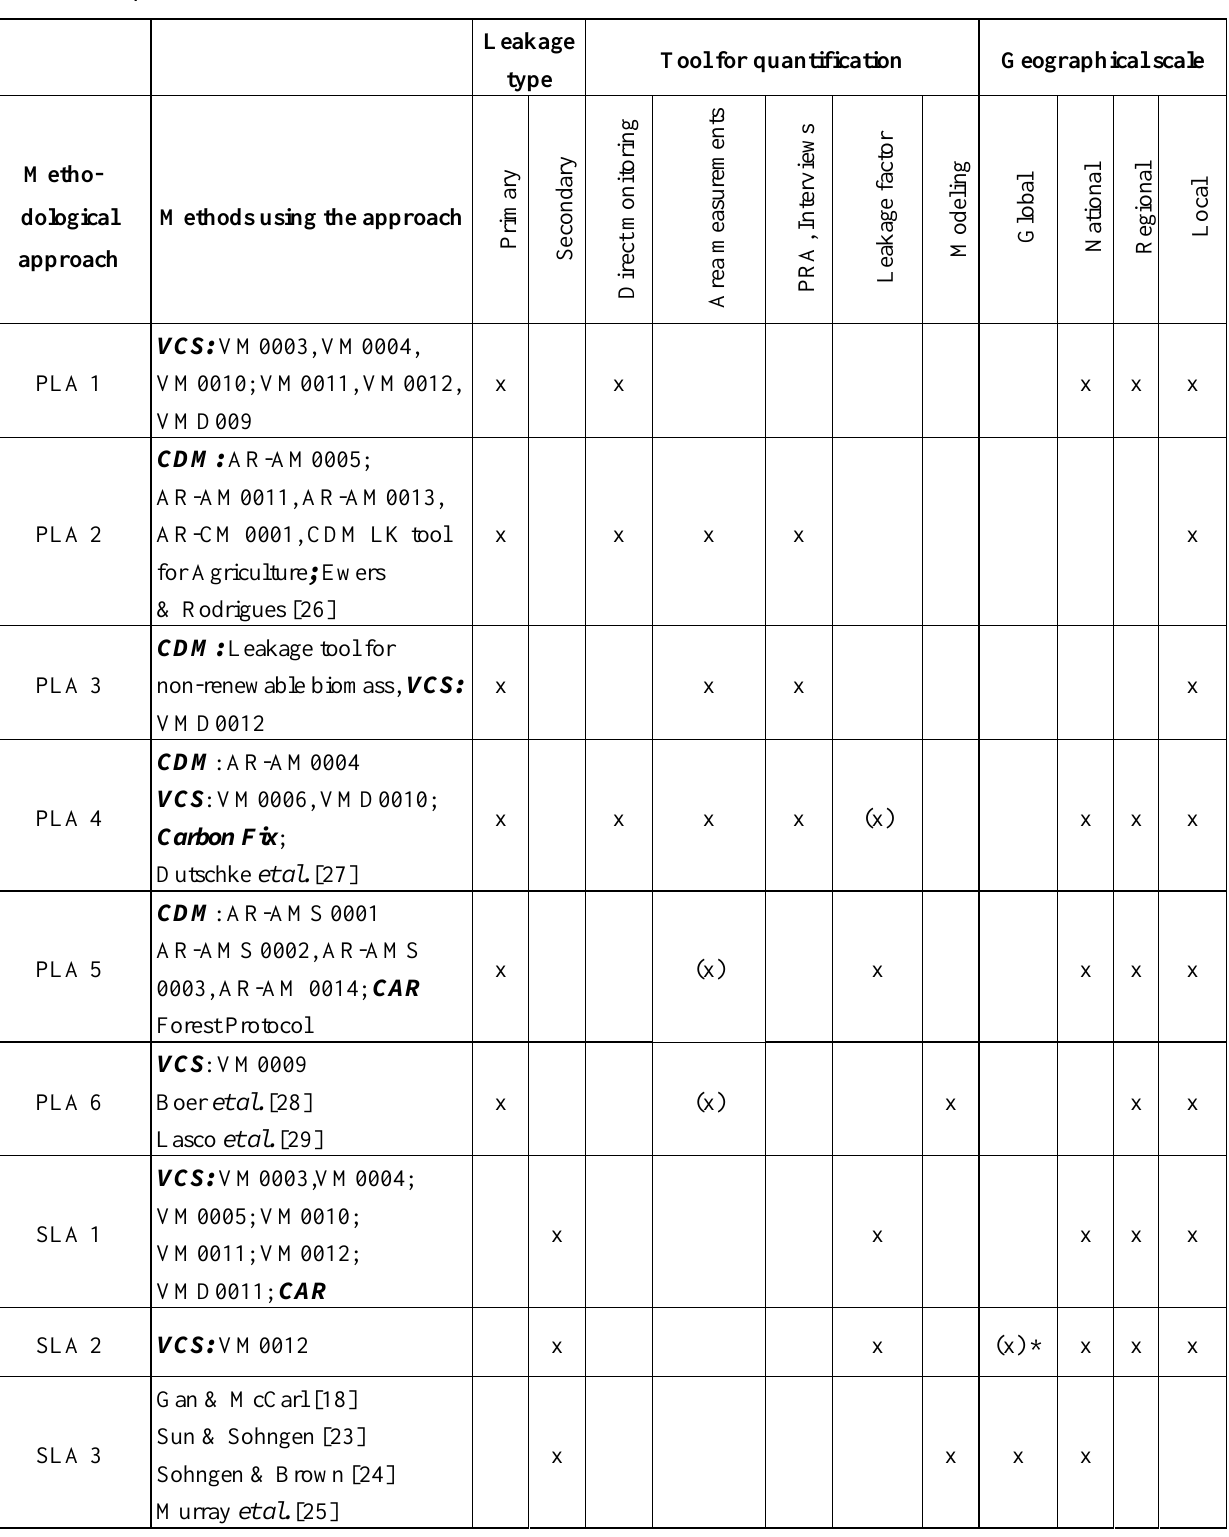
Table 3. Results of screening the methodological approaches for the basic leakage characteristics 1–3. PLA—Primary Leakage Approaches, SLA—Secondary Leakage Approaches. Squared brackets indicate tools that are used by a method without being the main quantification